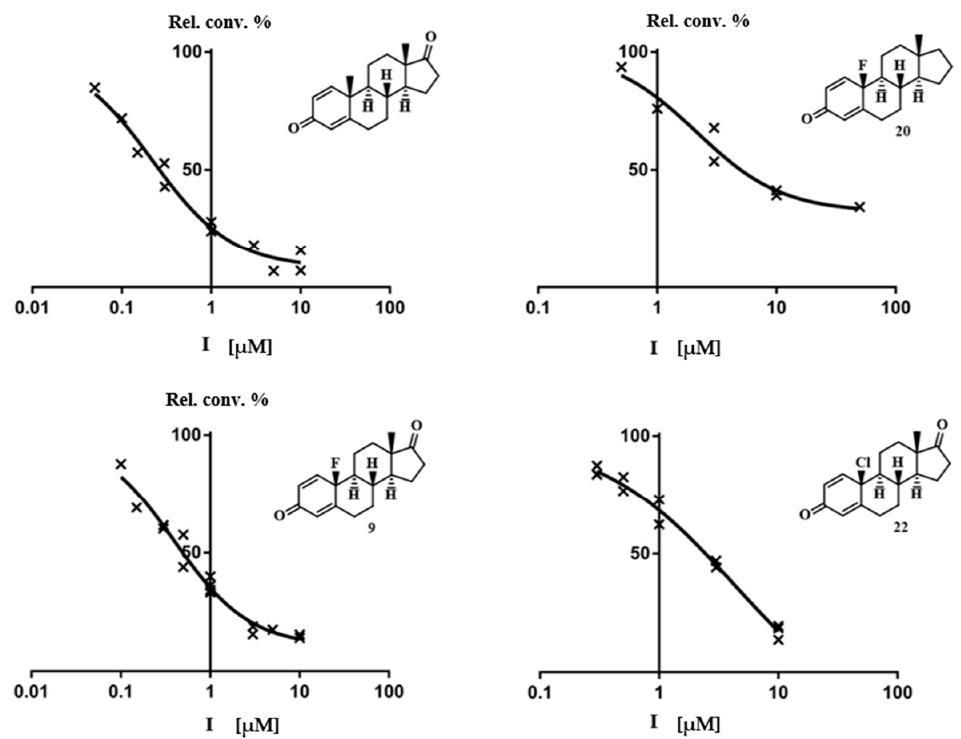
Figure 2. The concentration-dependent inhibitory action of the three potent compounds ( 9 , 20 and 22 ) and that of the reference compound androst-1,4-diene-3,17-dione. Table 4. The scoring values for compounds 9 , 17 , and 20 – 22